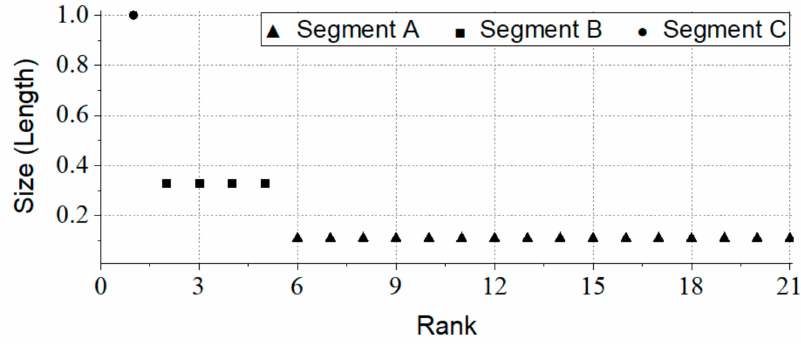
Figure 3. The rank-size plot of the line segments observed with the Koch curve.